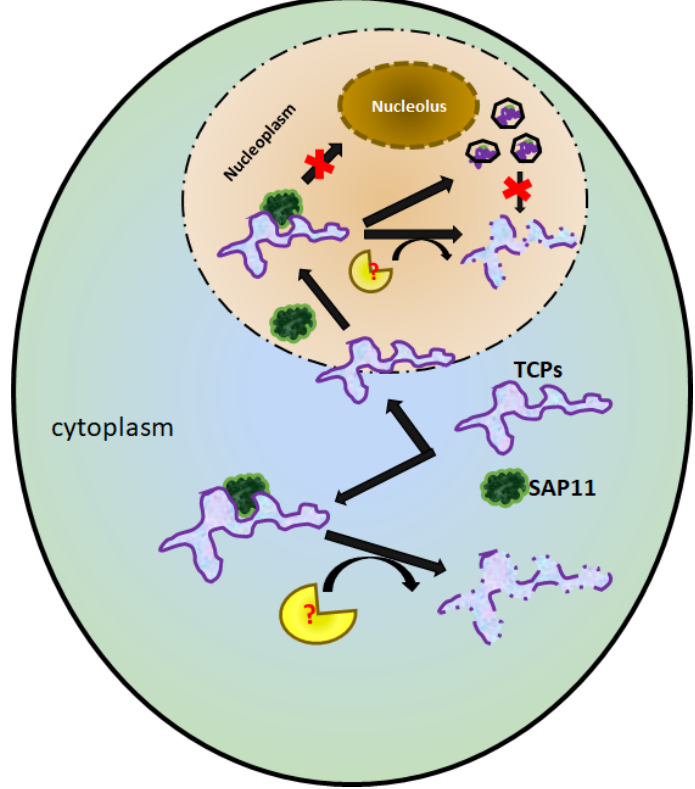
Figure 8. The activities of SAP11 PM19 on AtTCPs. In the cytoplasm, the SAP11 () binds TCPs () and the TCPs are destabilized (). The SAP11 and TCPs might separately migrate to the nucleus, and there SAP11 binds TCPs, resulting in either destabilization of the TCPs or relocalization of the TCPs, which can form cajal body complexes (). is unknown TCP destabilizing machinery. is an inhibi- tion.